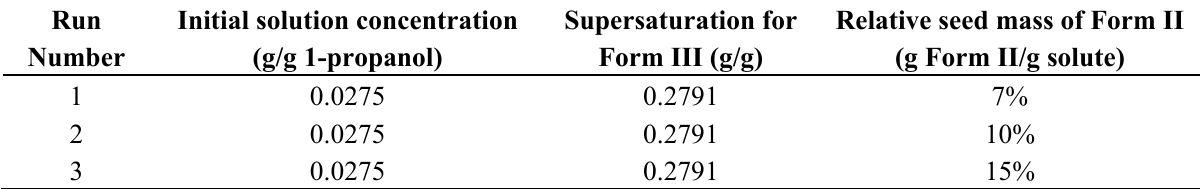
Table 4. Experiment conditions for polymorph transition trials in the isothermal